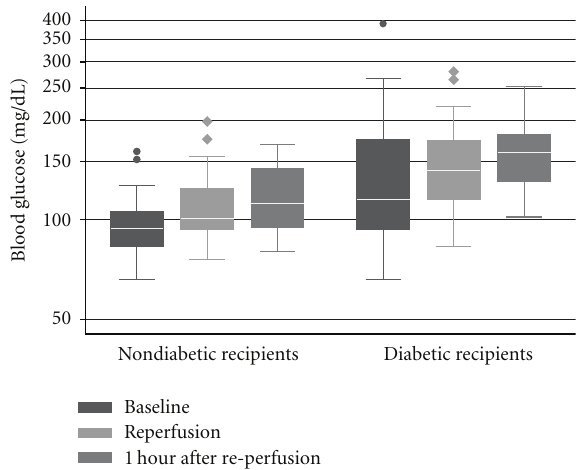
Figure 1: Pattern of intra-operative glucose levels for diabetic ( n = 18) and nondiabetic patients ( n = 21) during kidney transplantation. Whiskers span the 5th and 95th percentiles of all data. Dots represent outliers.